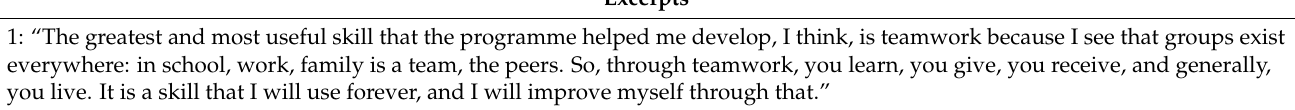
Table 4. Excerpts for Study